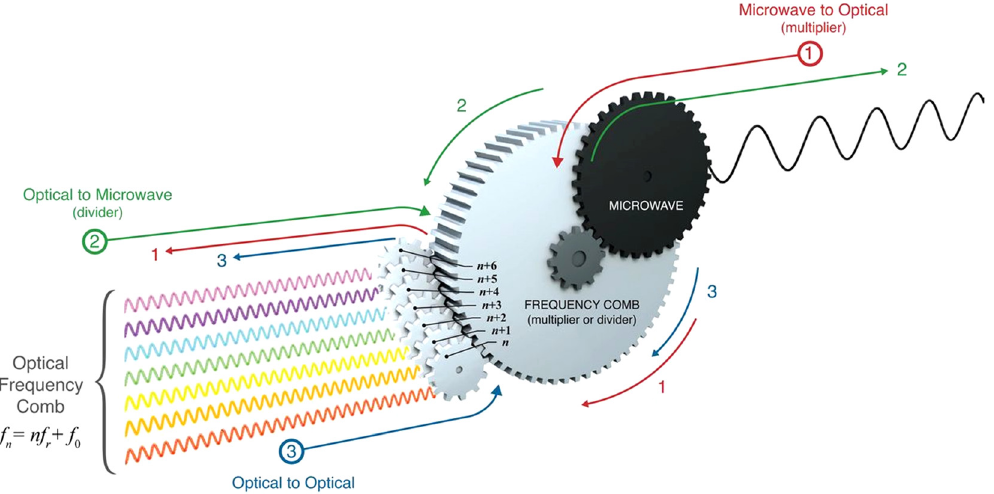
Figure 6: Metaphorical sketch of the correlation between optical and microwave frequencies by an optical frequency comb. The frequency comb provides the time standard while interconnecting the microwaves and optical frequencies coherently. The optical frequency comb has three bidirectional, simultaneous modalities, that can operate on phase coherently linking between the optical domain of the EM spectrum and the microwave domain of the electronics. As shown in red line “ 1, ” the input microwave frequency is multiplied by about five orders of magnitude to appear in the optical frequency domain as equally spaced optical waves. The green line “ 2 ” shows the opposite mechanism to process “ 1, ” and the input high-frequency optical wave is scaled down into the microwave region. Finally, blue line “ 3 ” describes the spectral transformation between an optical wave array. It occurs when an optical input field modulates the comb, and its phase is coherently coupled with the other frequencies of the optical field